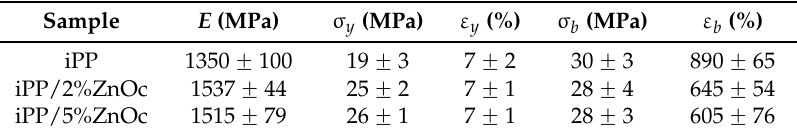
Figure 9. Stress–strain curves of iPP and iPP/ZnOc films. Table 3. Stress–strain parameters of iPP and iPP/ZnOc composites.